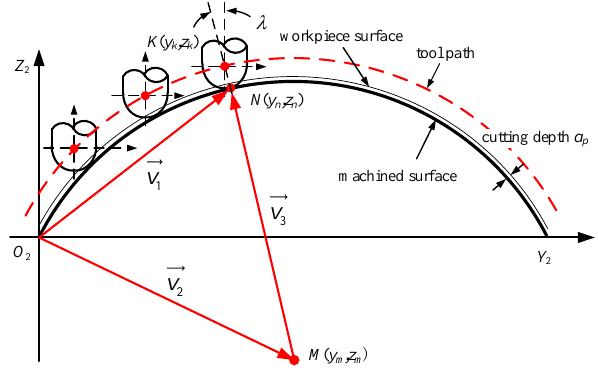
Figure 2. Schematic diagram of the milling process of convex curved workpieces.